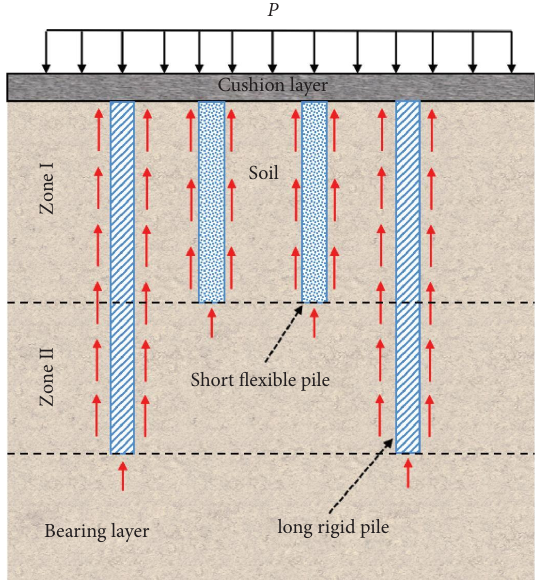
Figure 1: Te schematic diagram of the long-short pile composite